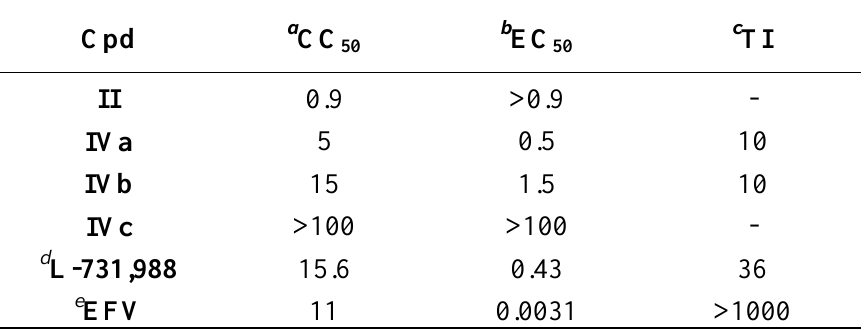
Table 1. Cytotoxicities and Antiviral Activities of Ι Va-c